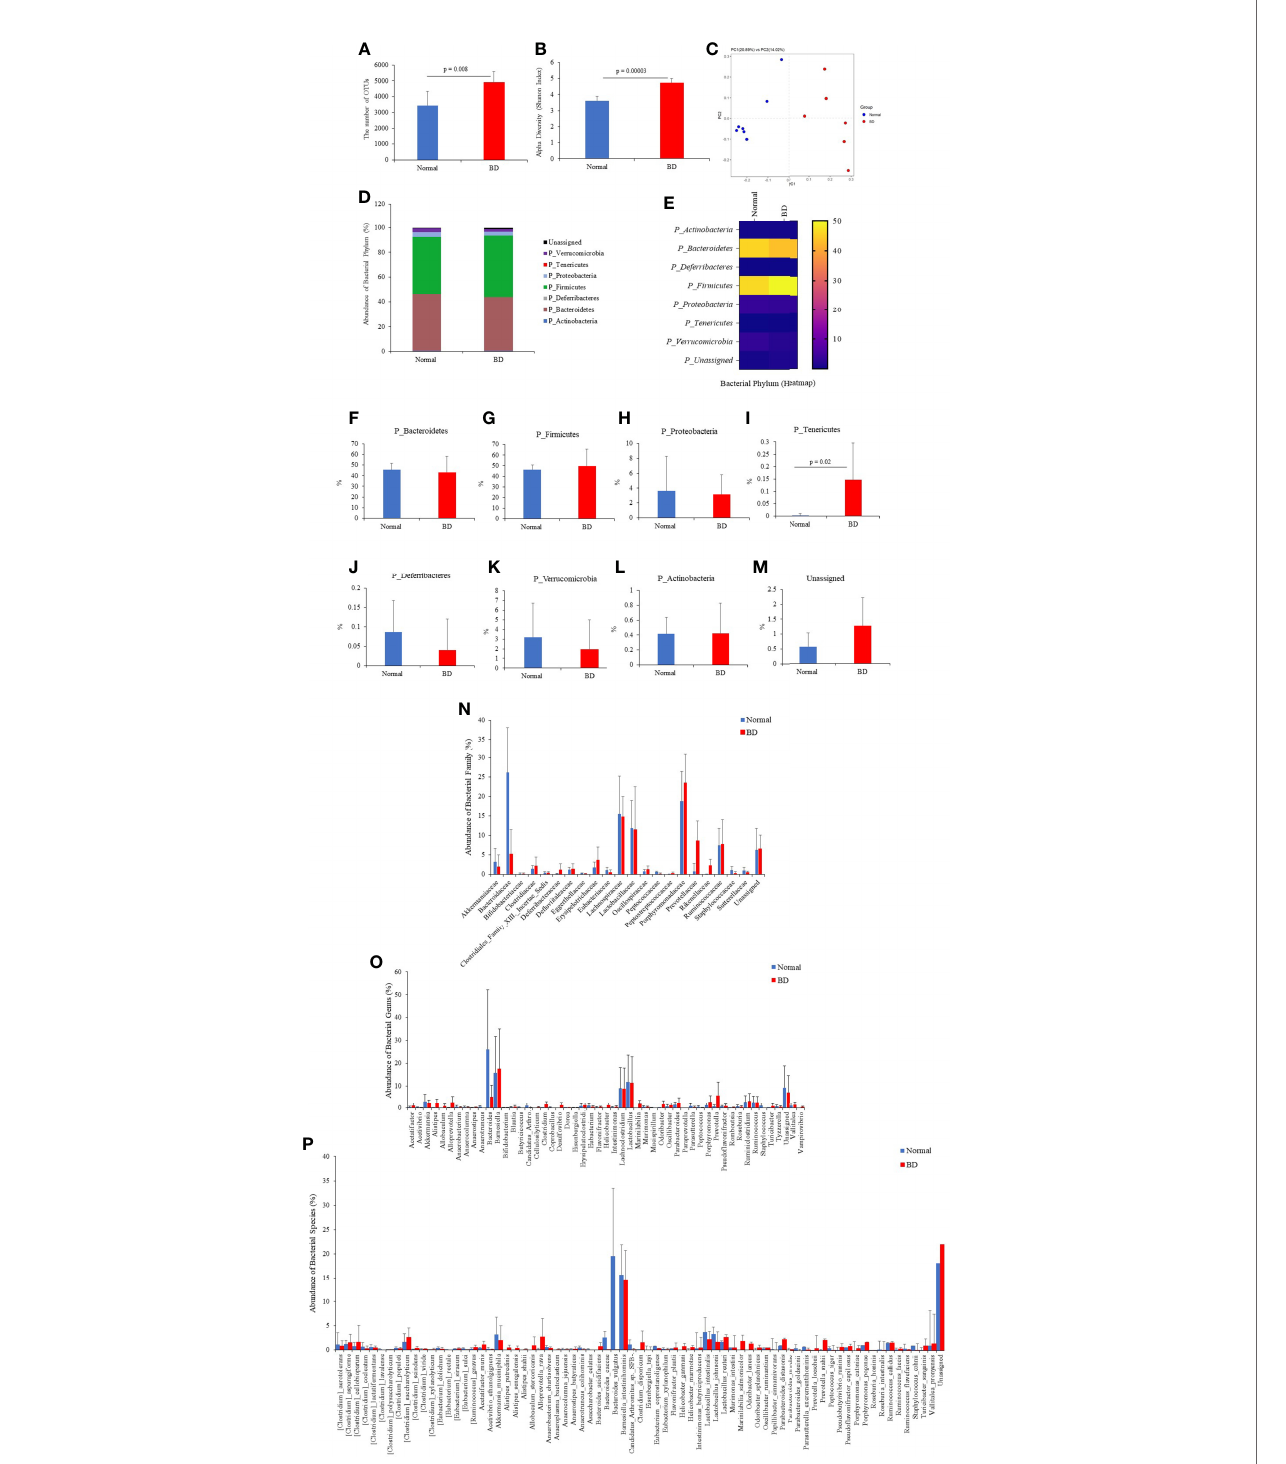
FIGURE 4 | Fresh fecal samples were collected from normal (n = 7) and BD mice (n = 6), and metagenomic analysis was performed. Sequencing data from 16S rRNA V3 and V4 amplicons were used to perform microbiome analysis. BD mice 16S rRNA amplicon metagenomic analysis revealed an altered gut microbiome composition compared to normal mice. It showed the operational taxonomic units (OTUs) (A) , alpha diversity by the Shannon index (B) , and beta diversity by principal coordinate analysis (PCoA) (C) . The number of phyla (D – M) , families (N) , genera (O) , and species (P) showed signi fi cant differences in fecal 16S rRNA sequencing between the normal and BD mice. The p-value was determined by the Mann-Whitney U